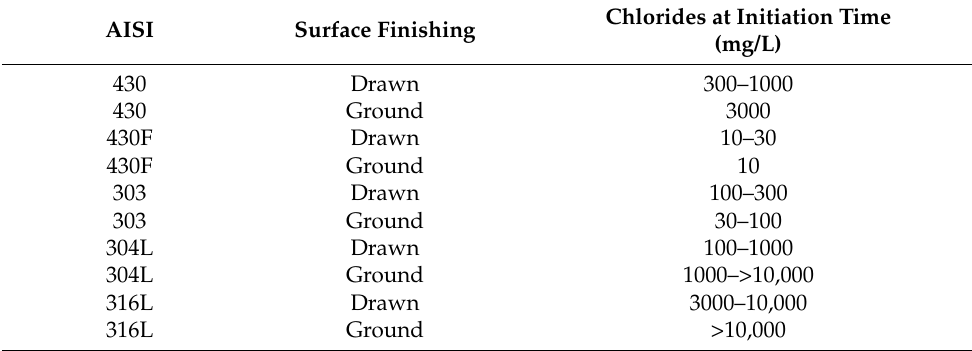
Table 5. Critical chloride concentration in potentiostatic polarization